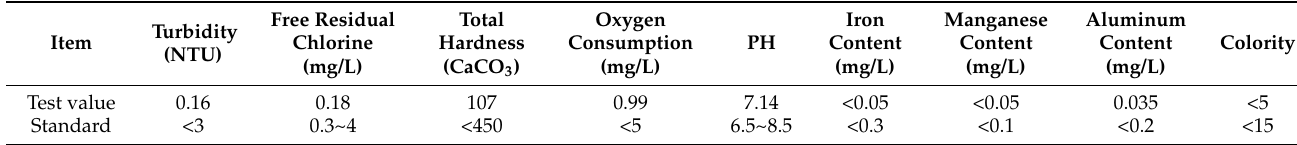
Table 2. The quality of the regular tap water (RW).